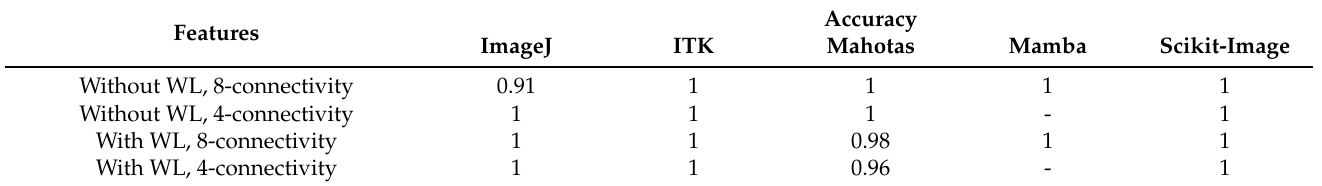
Table 3. Segmentation accuracy for various watershed implementations in comparison with SMIL.